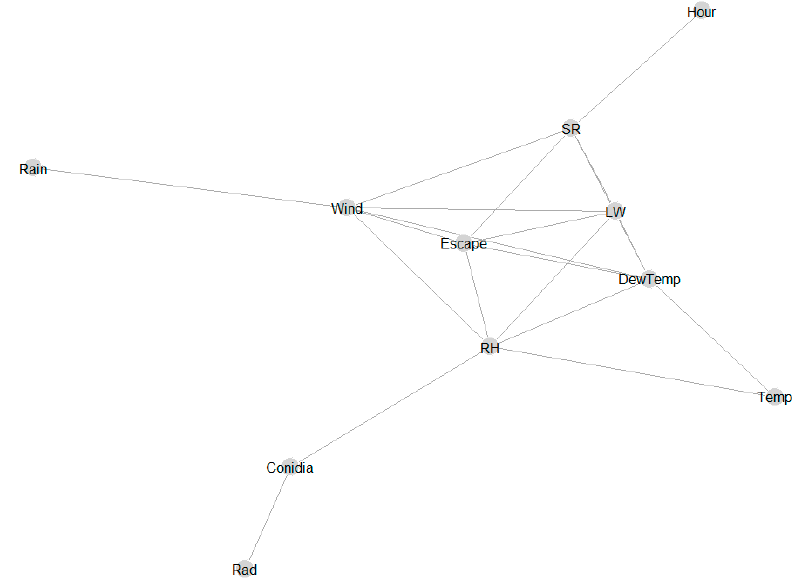
Figure 5. A graphical model showing the conditional dependence of weather variables and conidia concentrations at each hour in the day. Variables that are connected by a line are conditionally dependent or correlated significantly and vice versa. The weather variables were relative humidity (RH), temperature (Temp), wind speed (Wind), dew point temperature (DewTemp), leaf wetness (LW), solar radiation (Rad), and rainfall (Rain). The probability that conidia will be released is identified by the variable spore release (SR), and the probability that conidia will escape from the canopy is named escape (Escape).